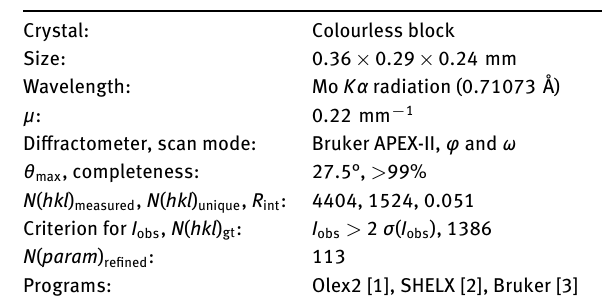
Table 1: Data collection and handling.